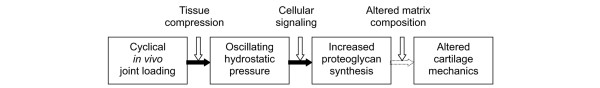
A proposed mechanism by which cyclical loading leads to changes in articular cartilage mechanical properties. Hydrostatic pressure of cartilage tissue is increased through compression caused by cyclical in vivo joint loading. With loading at physiological frequencies and amplitudes, changes in cellular signaling pathways lead to a detectable increase in proteoglycan synthesis. Changes in chemical composition of cartilage extracellular matrix eventually lead to changes in mechanical properties of the tissue in general.